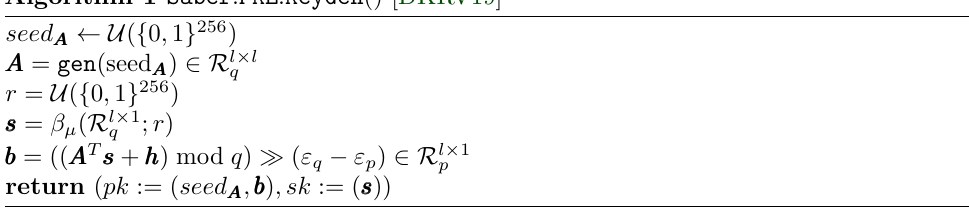
Algorithm 1 Saber . PKE . KeyGen ()